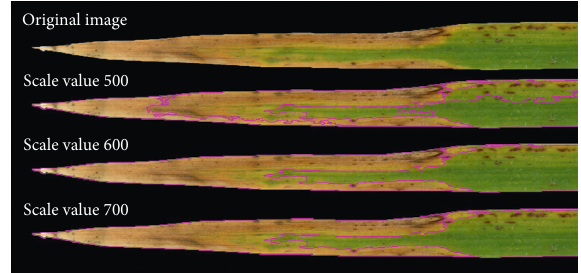
Figure 5: Segmentation under different scales for extraction of the yellowish brown leaf margin